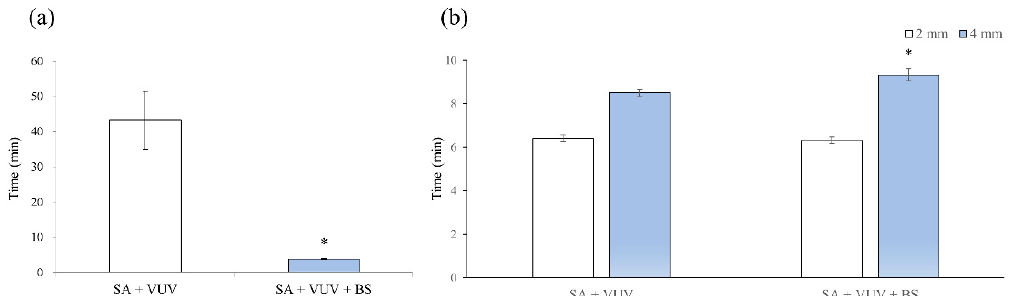
Figure 4. In vitro test of static and dynamic surface wettability: ( a ) time (min) to reach the top of the implant fixture; ( b ) time (min) to reach 2 mm and 4 mm above the horizontal plate, respectively. SA + VUV, an SA surface with vacuum-UV treatment; SA + VUV + BS, an SA surface coated with a pH- buffering agent after vacuum-UV treatment. Mean ± SD, * p < 0.05 by Kruskal–Wallis test.